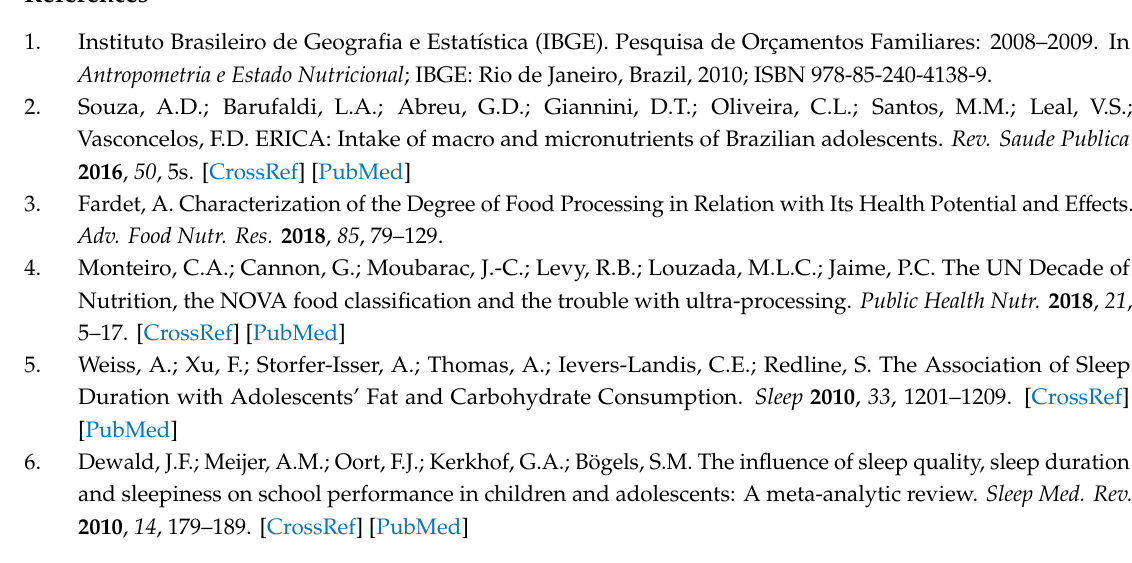
Figure S1: Directed acyclic graph (GAD) on food consumption according to processing level and sleep quality in